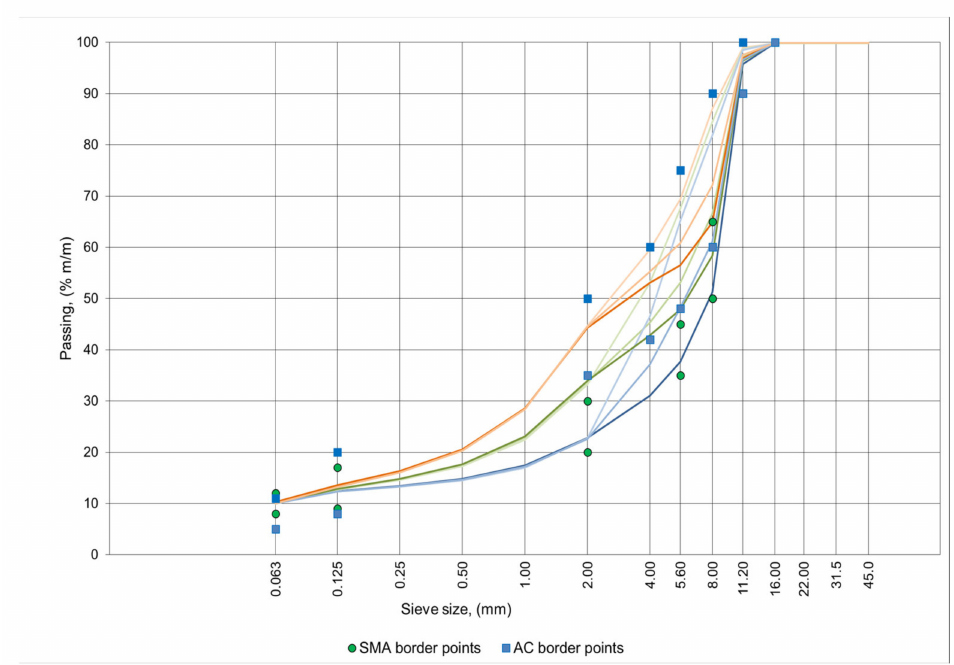
Figure 1. Grading curves of mineral